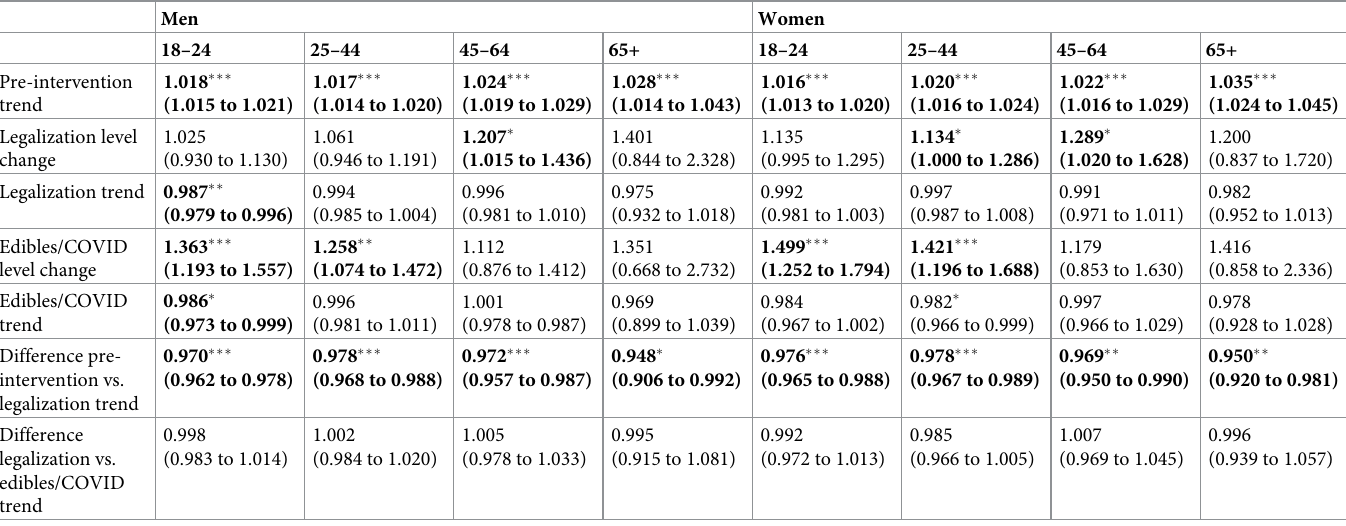
Table 3. Associations between cannabis policies and ED visits in Southern Ontario using negative binomial regression with censored months in the early stages of COVID-19